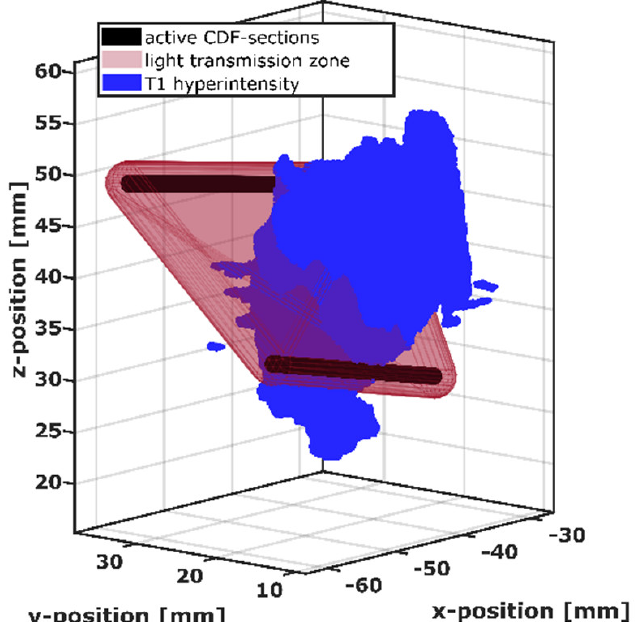
Figure 2. Visualization of the intersection between the light transmission zone (red) of the active cylindrical diffuser fiber (CDF) sections of one CDF-pair (black) and the intrinsic T1 hyperintensity volume (blue).